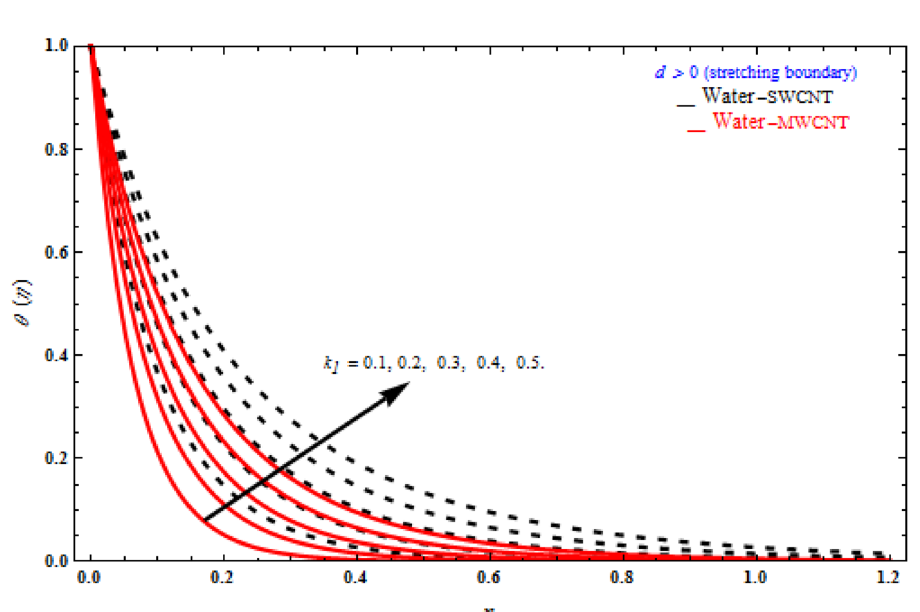
Figure 11. Impact of k 1 on temperature profile with M = 1, Da -1 = 1, N R = 1, τ = 90° for stretching